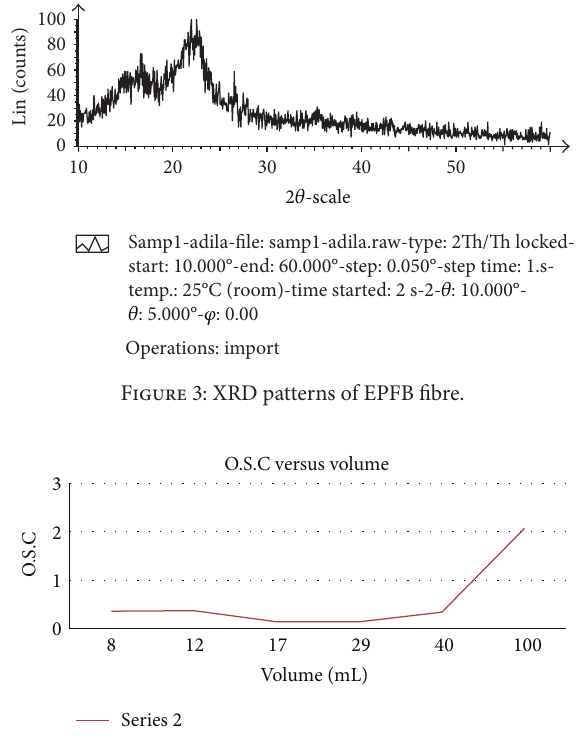
Figure 4: Oil sorption capacity versus liquid volume.